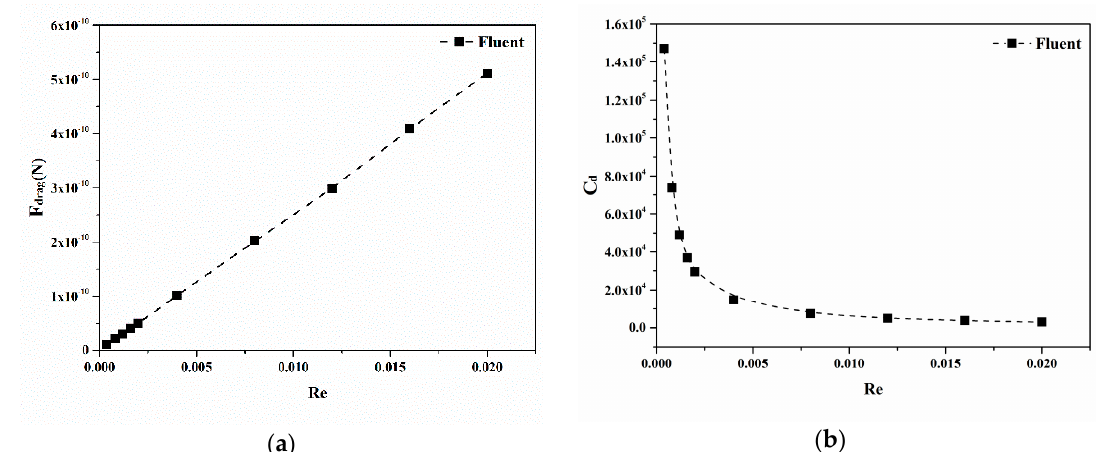
Figure 4. The drag force ( a ) and drag coefficient ( b ) versus the Reynolds number ranging from 4 × 10 − 4 to 2 × 10 − 2 .